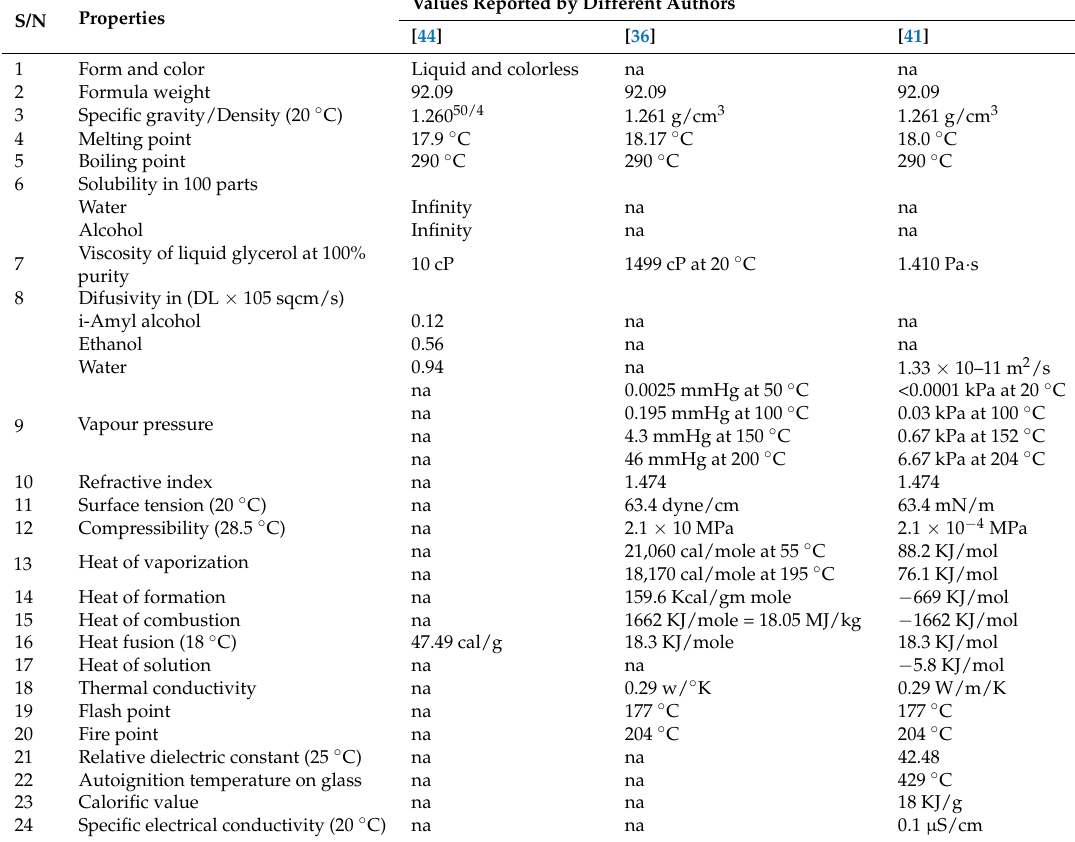
Table 2. Physico-chemical properties of glycerol reported by different